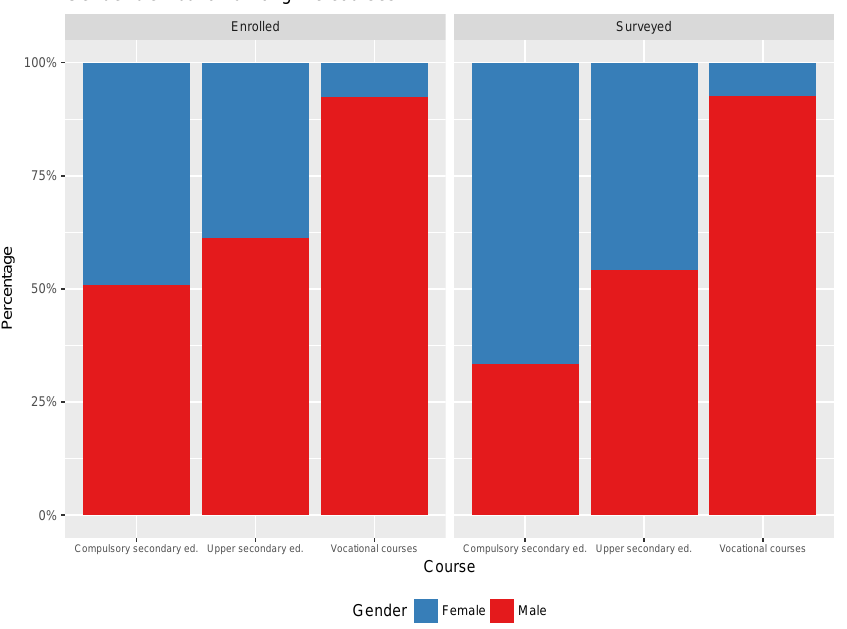
Figure 1. Distribution of gender among the students enrolled (on the left) and surveyed (on the